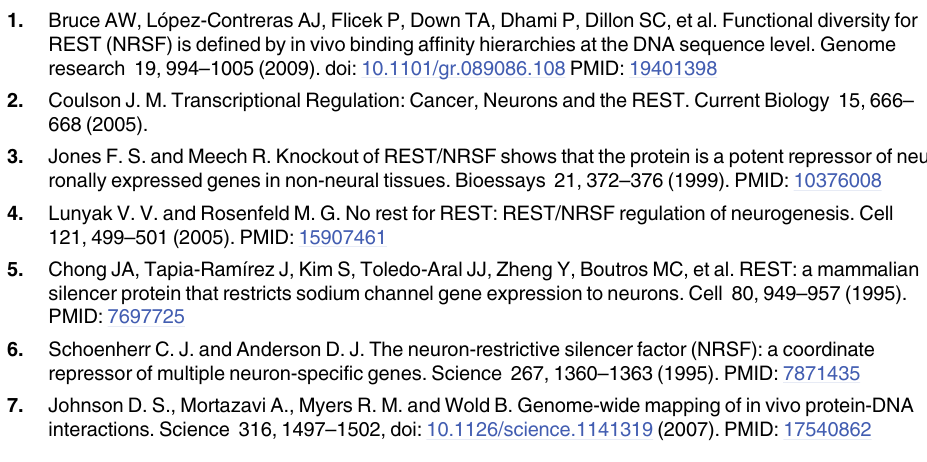
S1 Table. Karyotypes from REST KD, Control NT and siRNA hESC lines. Genomic stability was evaluated using either G-band karyotype analysis or copy number variant (CNV) analysis. The CNV analysis for siRNA targeted cells was performed by the UCLA Clinical Microarray Core. The G-band karyotype analysis for shRNA targeted cells was performed by Cell Line Genetics, an independent provider of cell line characterization services. In all cases where a non-clonal aberration was observed in only one of the twenty cells analyzed, the karyotype was deemed a technical artifact by Cell Line Genetics. REST shRNA targeted lines were genetically unstable whereas REST siRNA KD and control siRNA lines were found to be genetically